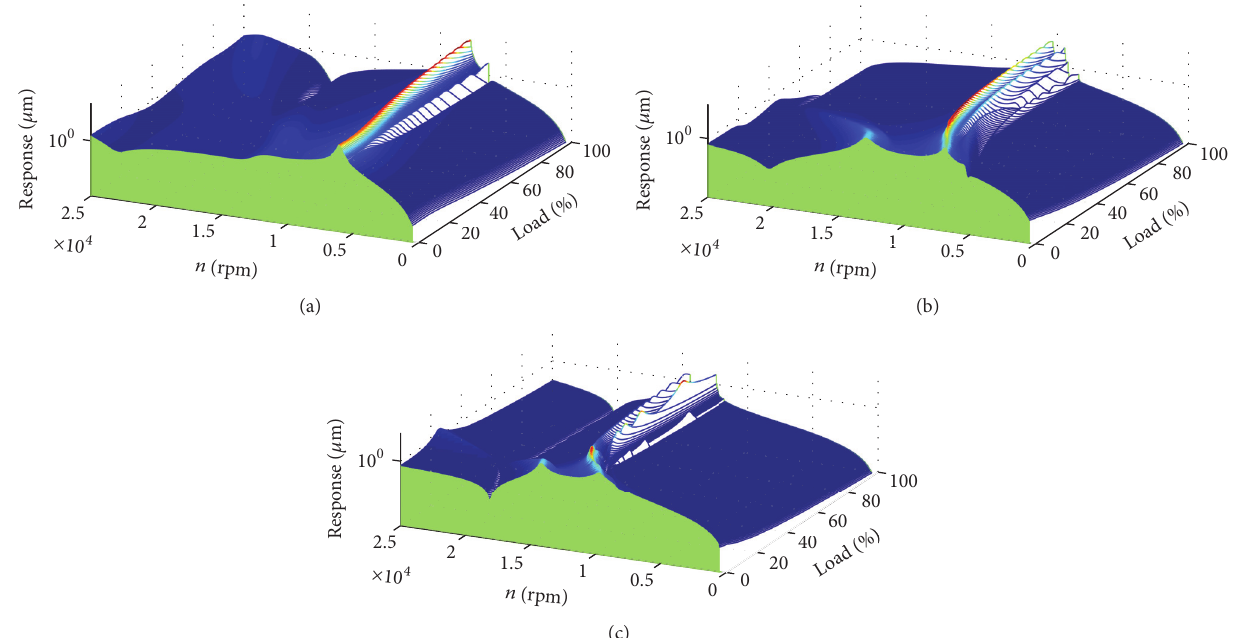
Figure 10: Unbalance response of three output shafts only considering dynamic coefficients under varying workload, (a) output shaft 1; (b) output shaft 2; (c) output shaft 3.